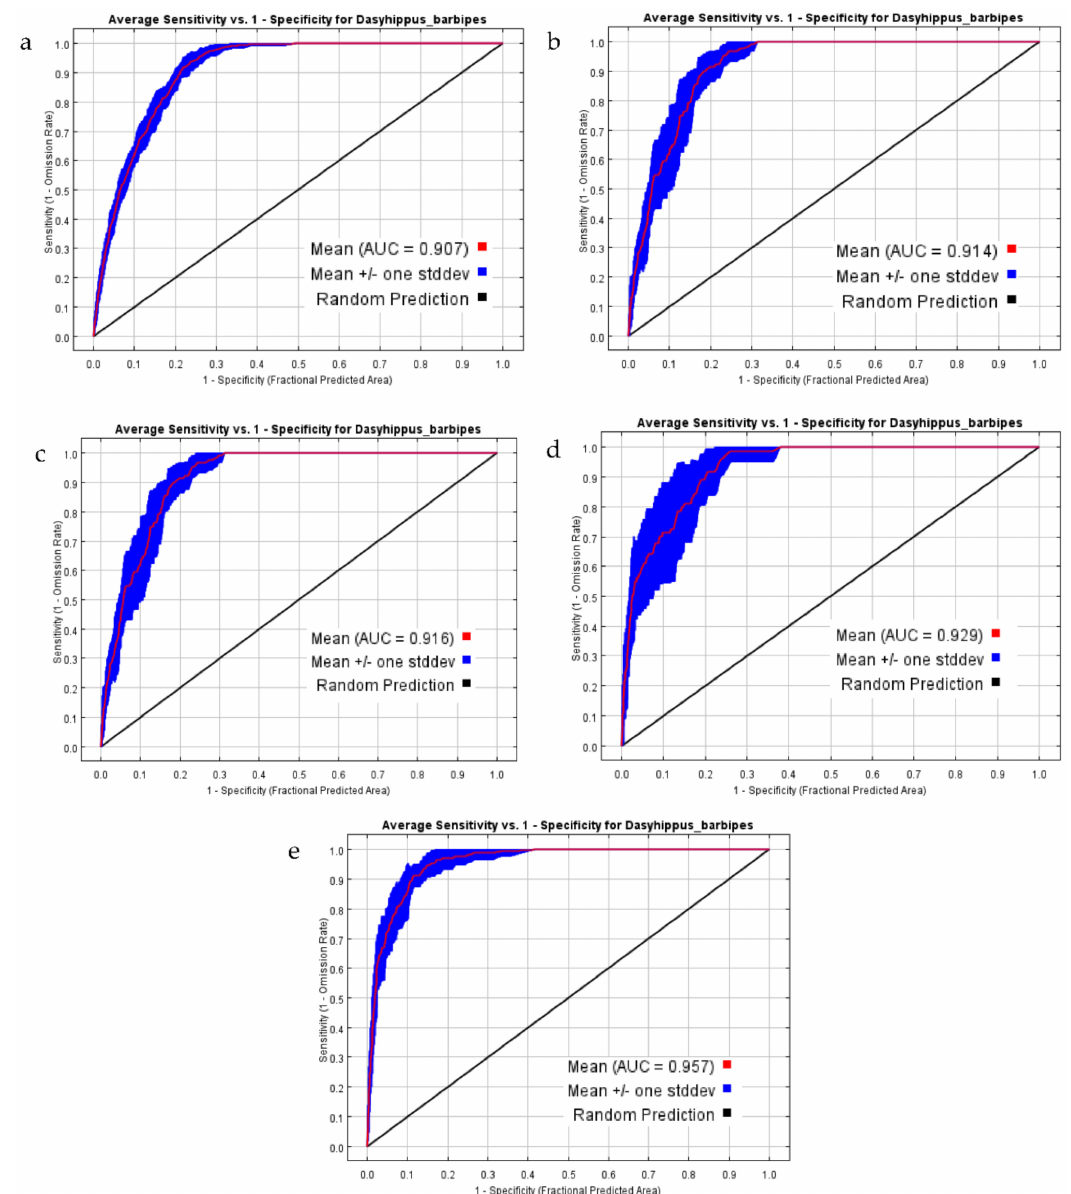
Figure 4. The average AUC values of the different density scenarios: ( a ) all survey points; ( b ) the low-density survey points; ( c ) the low–medium-density survey points; ( d ) the medium–high-density survey points; ( e ) the high-density survey